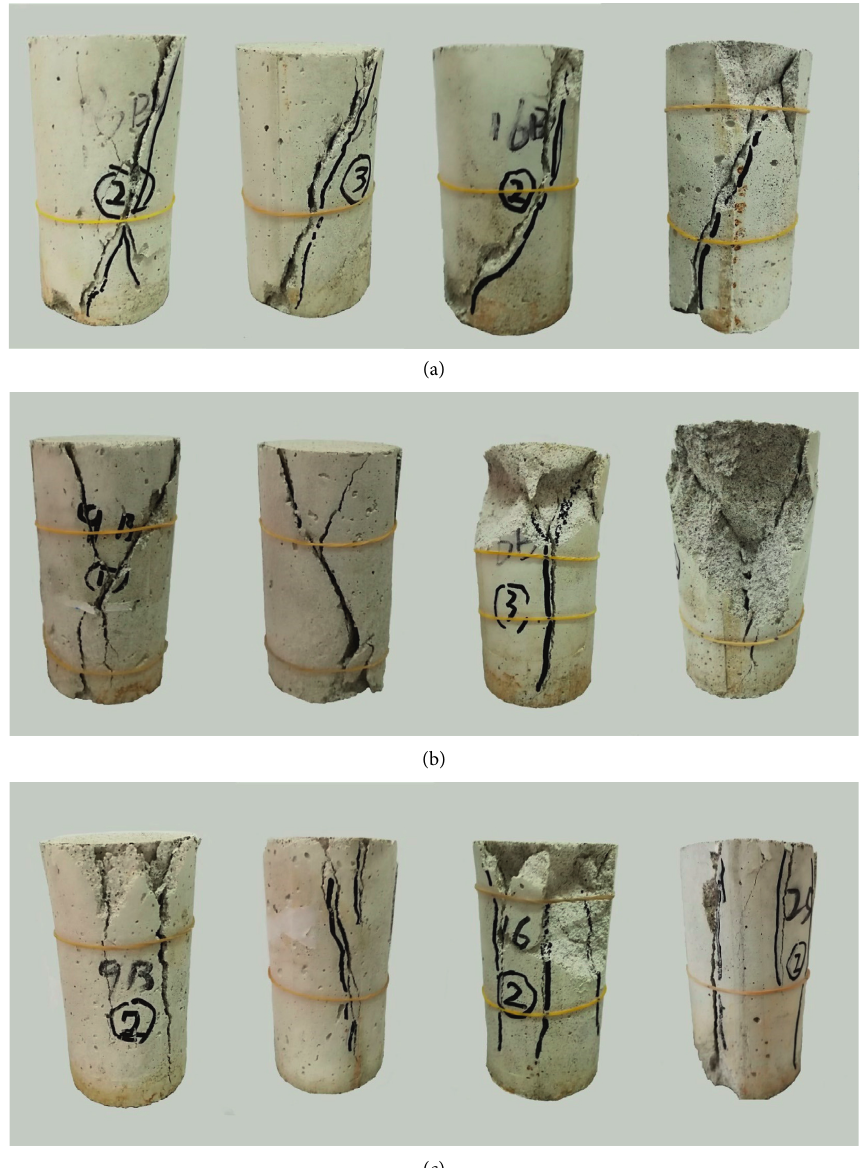
Figure 10: Three types of typical failure modes of uniaxial compression tests: (a) shear failure of single inclined plane; (b) Y-shaped tensile shear failure; (c) pure tensile